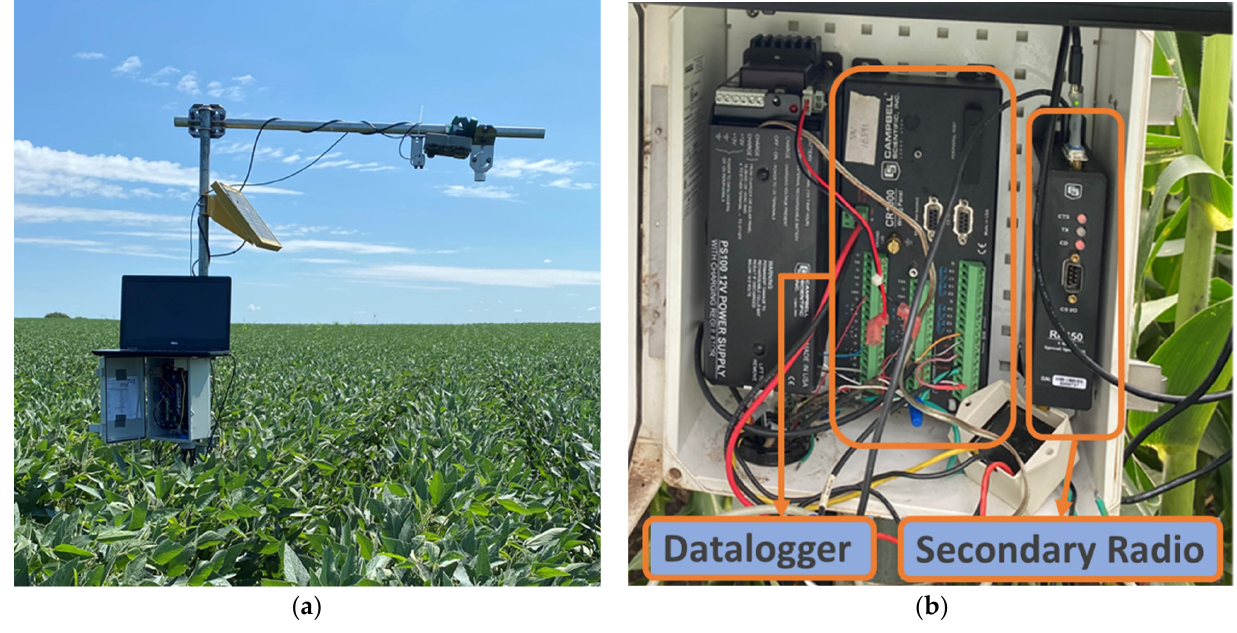
Figure 6. ( a ) Sensor node station comprising of infrared radiometer sensor sensing the crop canopy; ( b ) the layout of the datalogger along with the secondary radio and the power battery source.